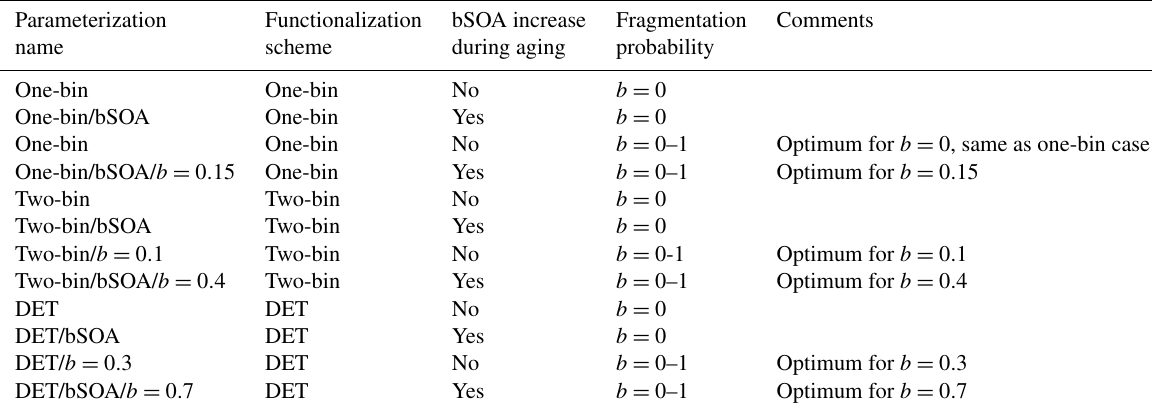
Table 1. Characteristics of the different parameterizations used in our simulations. Parameterization Functionalization bSOA increase Fragmentation